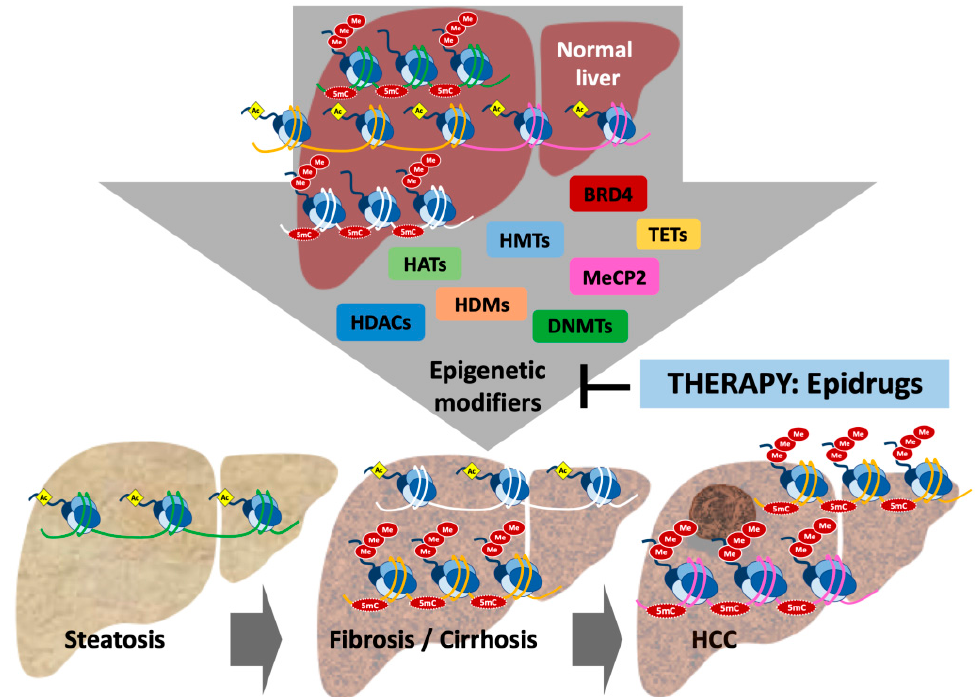
Figure 1. Epigenetic mechanisms control open and closed chromatin states, contributing to regulate gene expression. This drawing represents epigenetic changes described in the progression of chronic liver disease (see main text) such as DNA hypermethylation of tumor suppressor genes and histone acetylation of oncogenes. These changes are associated with the activity of different epigenetic modifiers, including histone methyltransferases (HMTs), histone demethylases (HDMs), histone acetyltransferases (HATs), histone deacetylases (HDACs), DNA methyltransferases (DNMTs), the ten-eleven-translocation (TETs) family of methyl-DNA dioxygenases, and the readers bromodomain-containing protein 4 (BRD4) and methyl-CpG-binding protein 2 (MeCP2). These enzymes and protein adaptors add, remove, or read the epigenetic marks representing new therapeutic targets for a variety of inhibitors known as epidrugs.